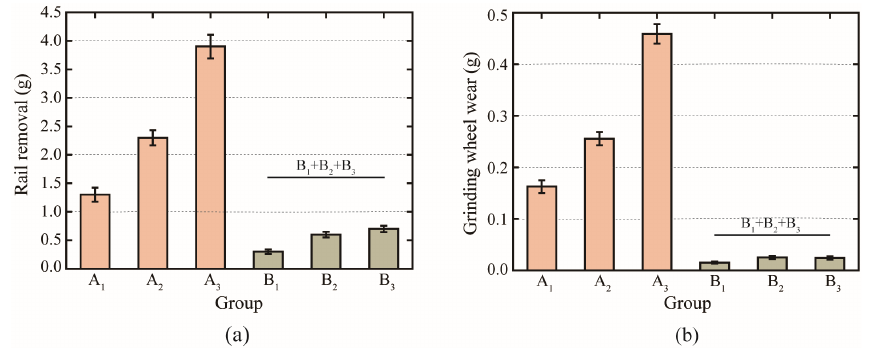
Figure 4. ( a ) Removal of rail samples by grinding wheels and ( b ) wear of grinding wheels at differ- ent grinding